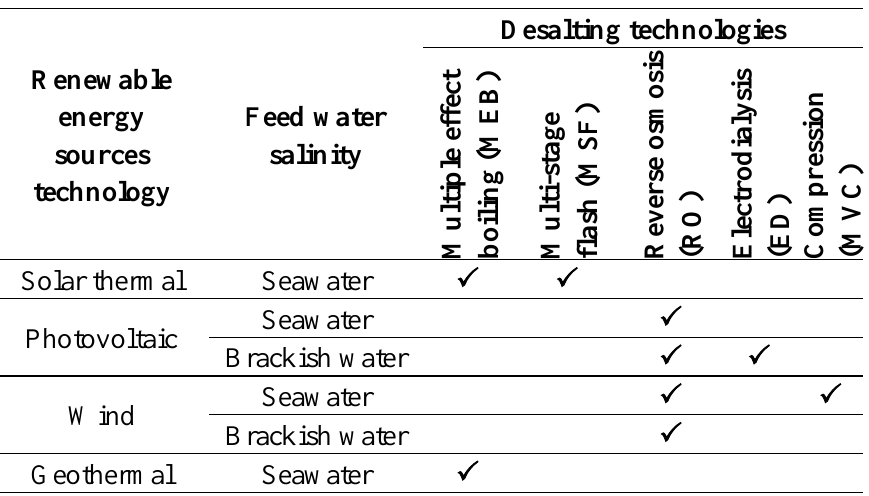
Table 1. Renewable energy sources (RES) desalination combinations